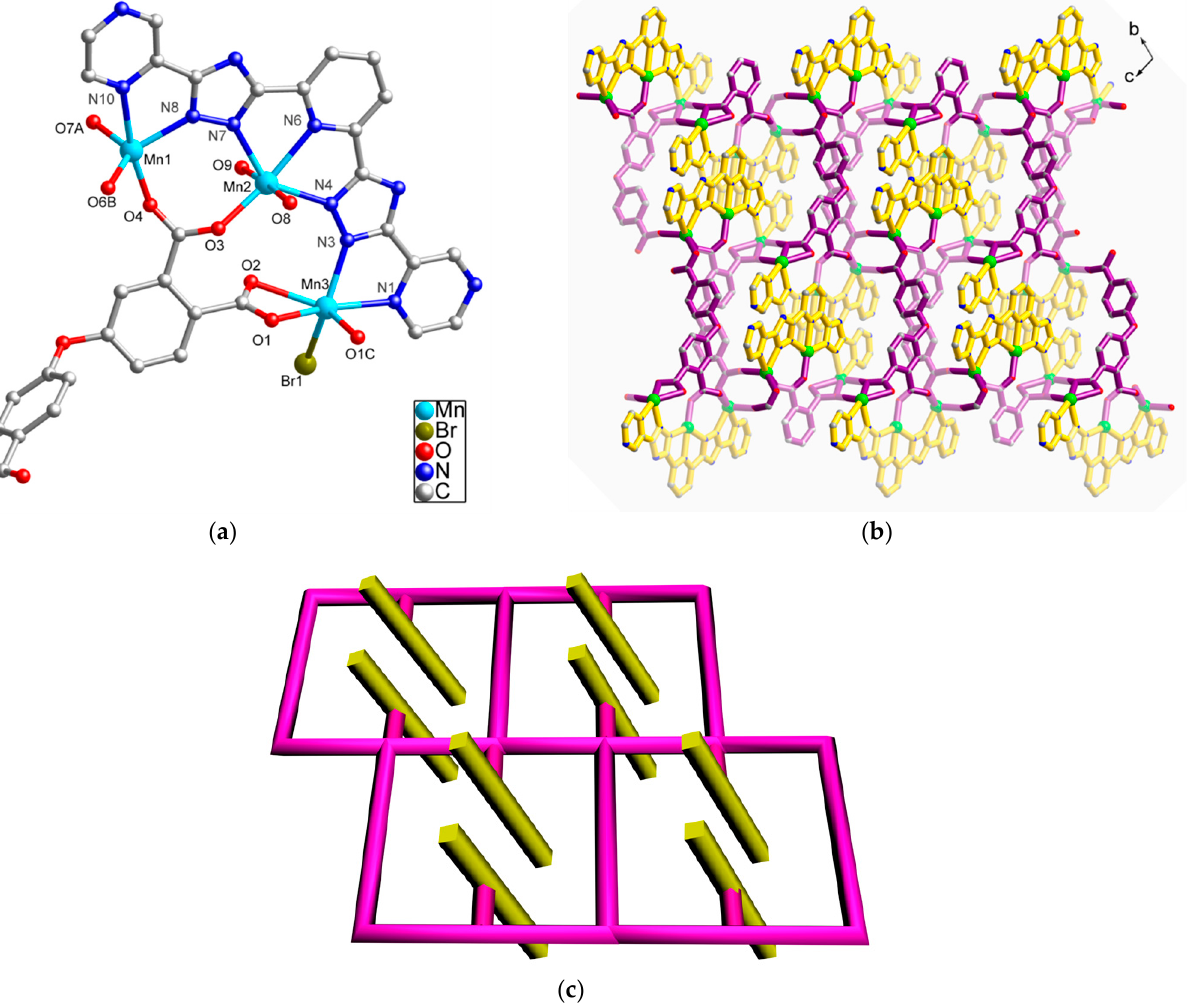
Figure 2. ( a ) Local coordination environment of Mn(II) ions in 2 . ( b ) 2D self ‐ threading architecture in 2 . ( c ) Schematic diagram of the 2D self ‐ threading structure, the coordinated ptptp 2 − ligands like inserted wedges are highlighted by ash blonde.